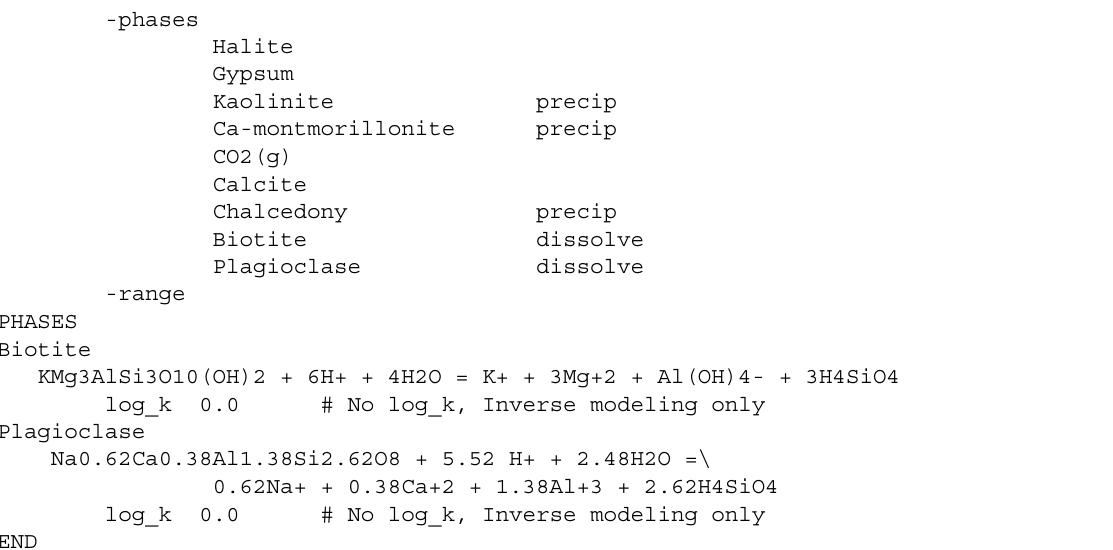
Table 47. Input file for example